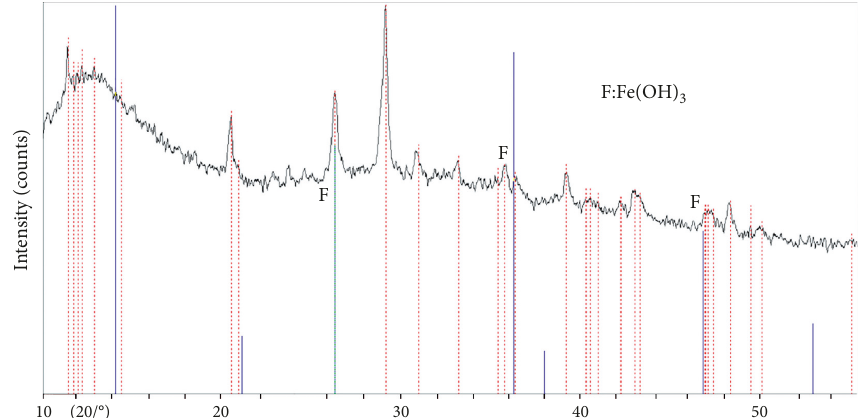
Figure 8: XRD analysis for reddish-brown powder.